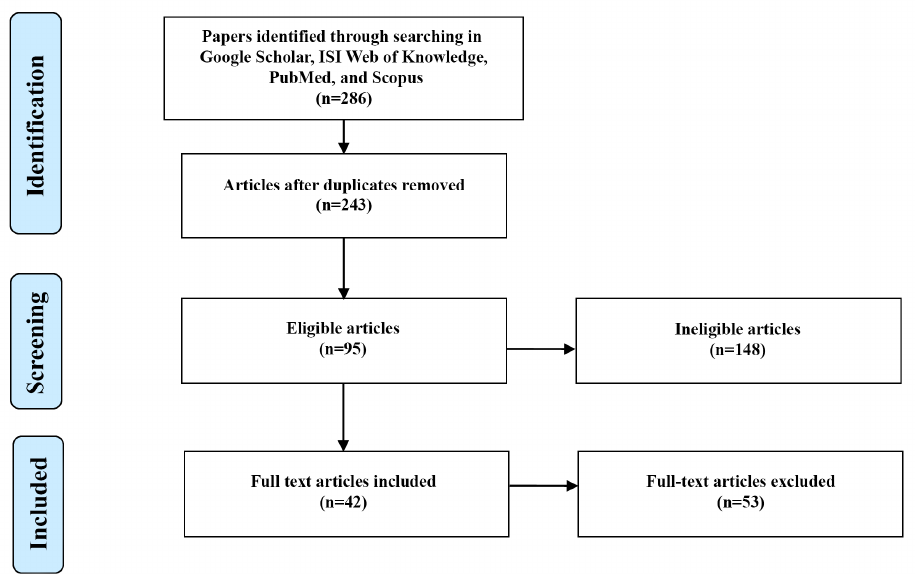
Figure 1. Selection procedure utilized in this study.